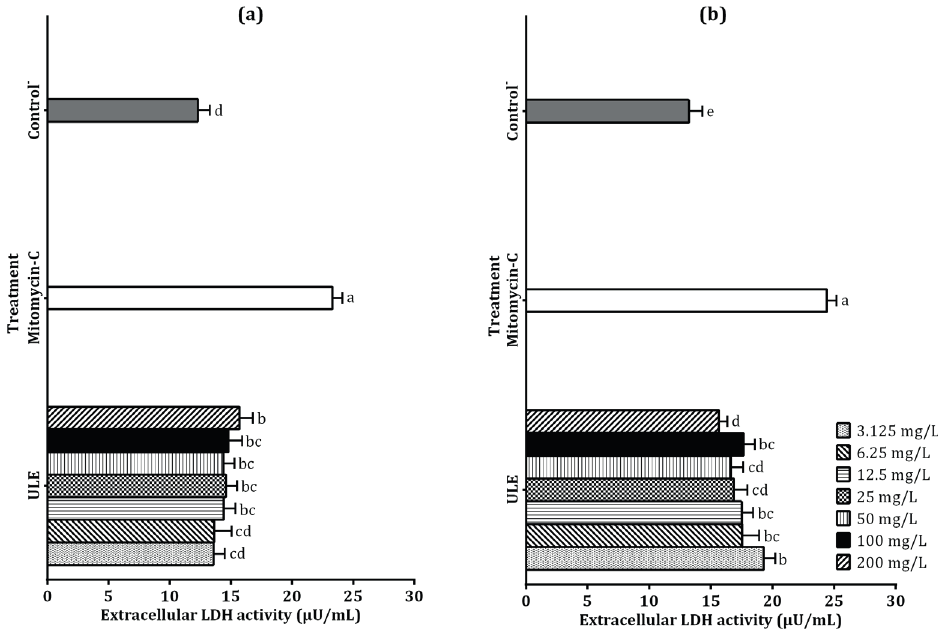
Figure 3 - LDH release levels in the cells exposed to ULE (a) for PMGN cells (b) for U87MG cells. each value is expressed as mean ± standard deviation ( n = 3). Values followed by different small letters differ significantly at p <